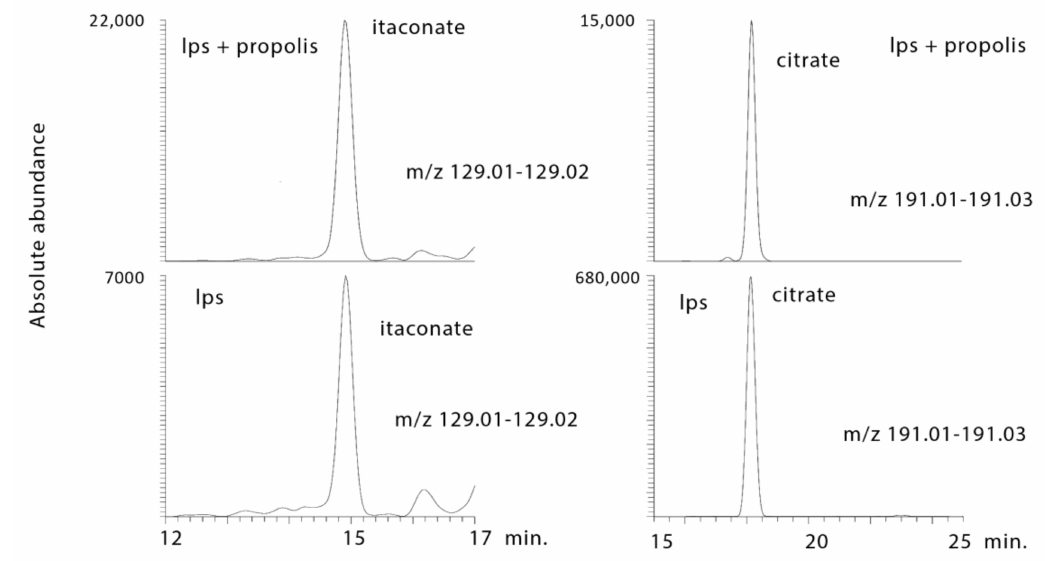
Figure 11. Extracted ion traces showing a decrease in citrate and increase in itaconic acid in LPS-stimulated macrophages treated with propolis.